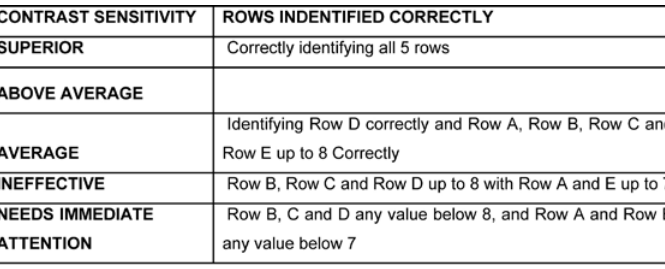
Table 2: The norms for contrast sensitivity with the use of the Functional Acuity Contrast Test. The results in brackets are the results obtained by Buys4.